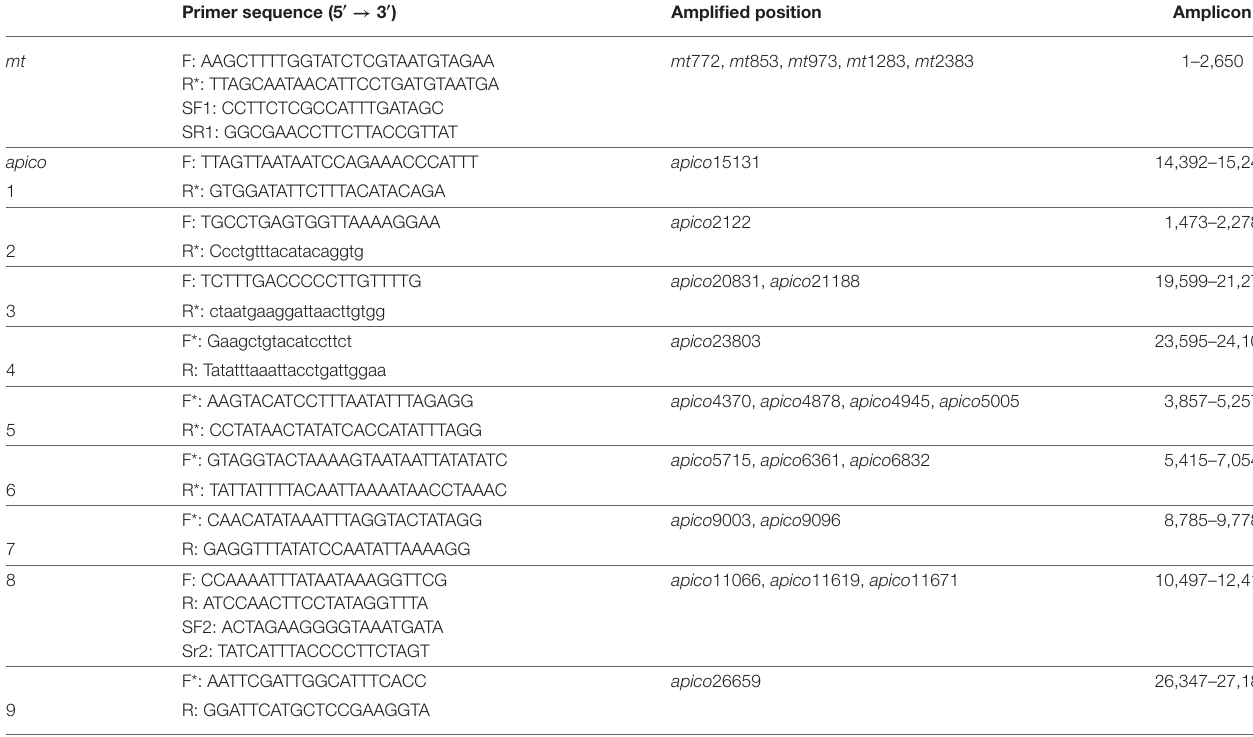
TABLE 1 | Primers used for polymerase chain reaction (PCR) amplification and sequencing of mt/apico . Primer sequence (5 ′ → 3 ′